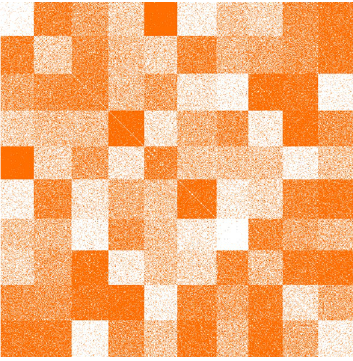
Fig. 3 Adjacency matrix of a random graph with k = 10 , and equal size blocks and 1000 nodes